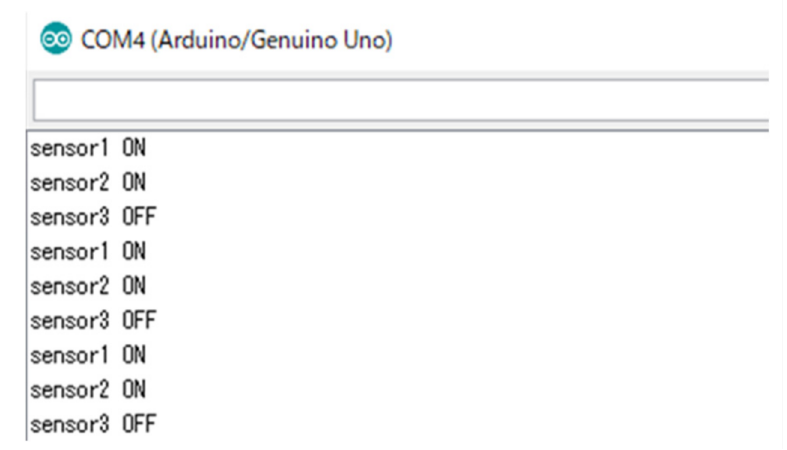
Figure 11. Output of distance sensors for fall prevention.